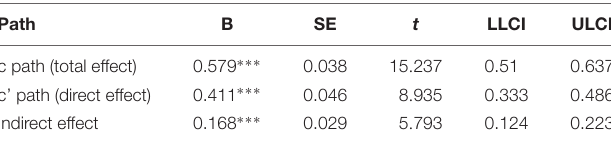
TABLE 6A | Mediation analysis of commitment between PsyCap and Well-being (total sample). Path B SE ULCI